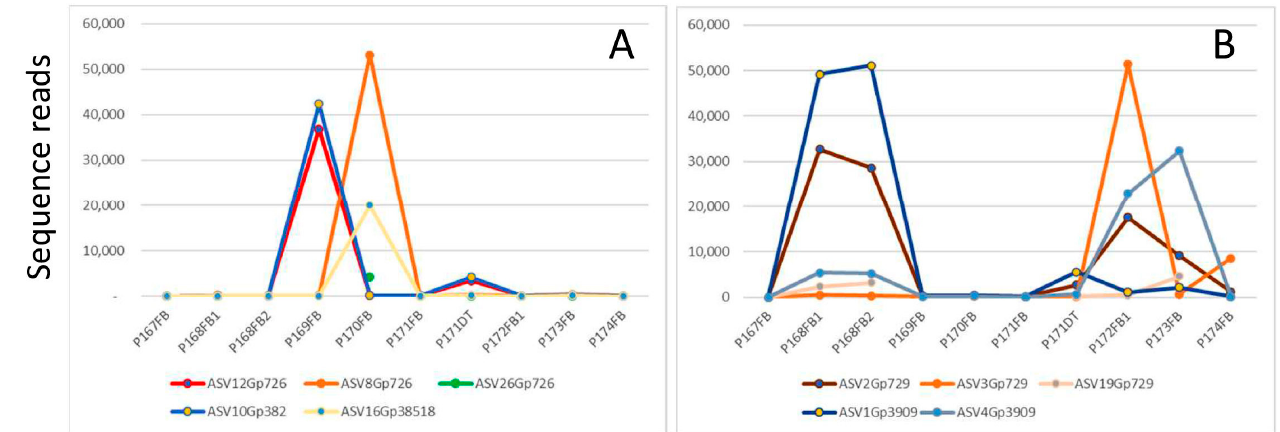
Figure 8. Intra-strain heterogeneity and inter-strain heterogeneity for Ganoderma species. Nine Ganoderma fruiting bodies and one decayed palm stem were collected from the same location (Clementi Avenue 5) and subjected to metagenomic analysis. Abundance for the Ganoderma genotypes is represented by their sequence reads in each sample. ( A ) Ganoderma australe : OQ566790/ASV12Gp726, OQ566788/ASV26Gp726, OQ566792/ASV8Gp726 are three genotypes of the Main OTU Gp726, and OQ566791/ASV10Gp382 and OQ566789/ASV16Gp38518 belong to the Main OTUs Gp382 and Gp38518, respectively. ( B ) Ganoderma orbiforme : OQ566787/ASV1Gp3909 and OQ566784/ASV4Gp3909 are two genotypes of the Main OTU Gp3909, and OQ566786/ASV2Gp729, OQ566785/ASV3Gp729 and OQ566783/ASV19Gp729 are three genotypes of the Main OTU Gp729.